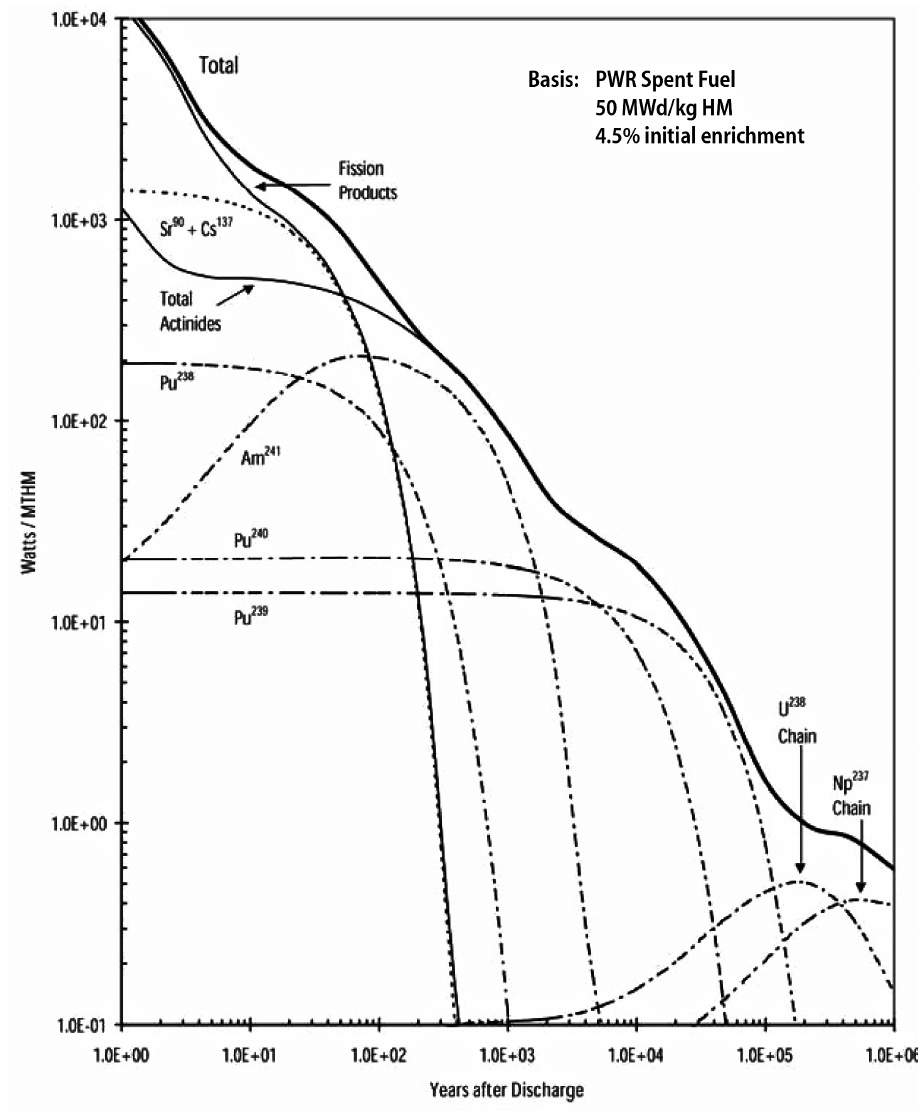
Figure 2. Decay heat profile of spent fuel [19]. Reproduced with permission from Massachusetts Institute of Technology. Massachusetts Institute of Technology, 2019.